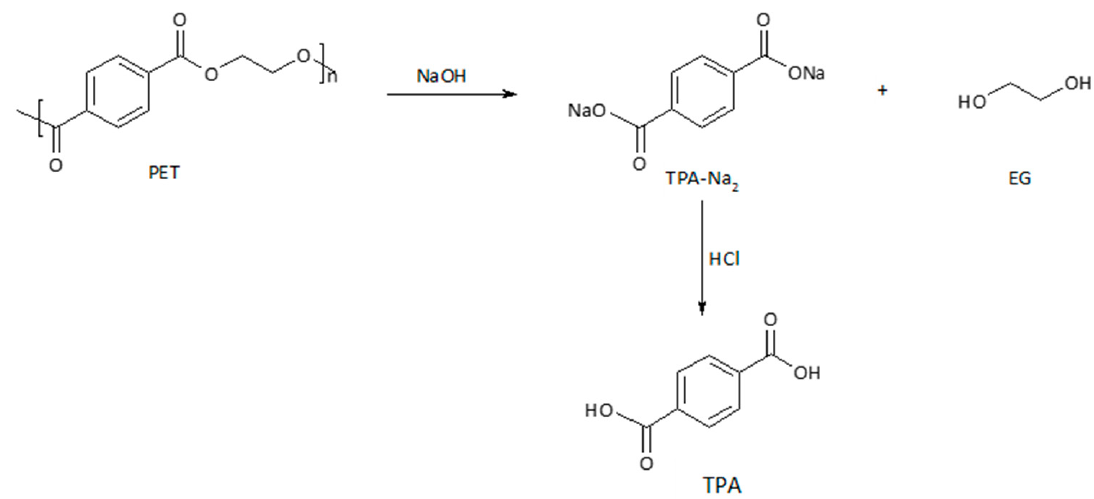
Figure 8. Alkaline hydrolysis of PET [40].